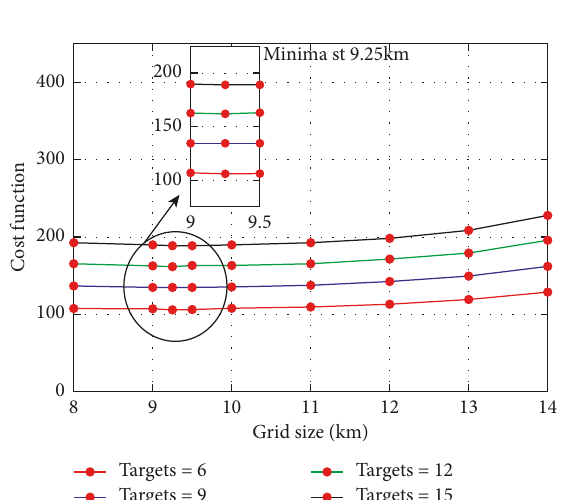
Figure 11: Cost function versus the grid size values for the different numbers of the targets. Optimal grid size is the same for different numbers of targets.